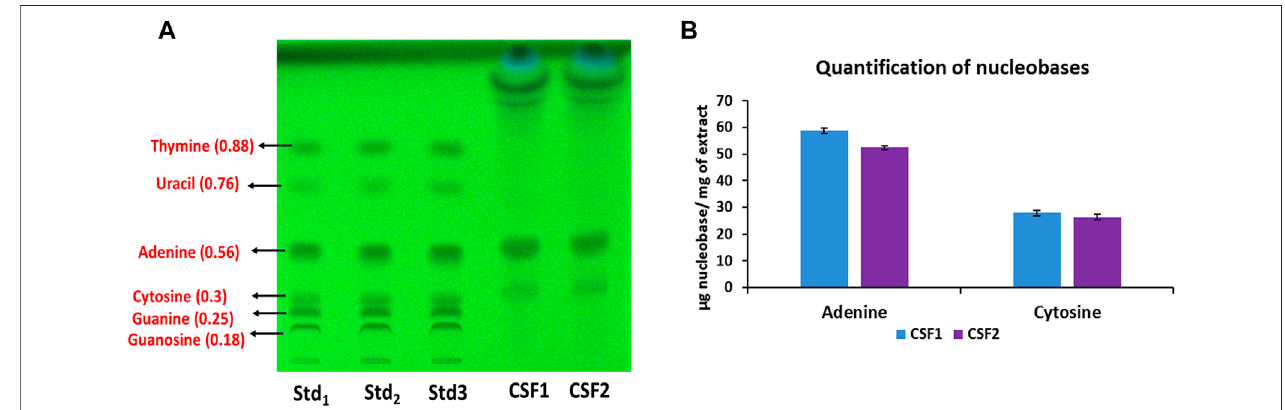
FIGURE3| HPTLCchromatogram at254 nmcon fi rmsthepresenceofadenineandcytosineinCSF1andCSF2extracts. Respective retardationfactor valuesare writteninparentheses (A) .Quantitiesdetectedfromdensitometric scanningarealsogiven (B) .Laneslabelled Std 1 ,Std 2 and Std 3 contain0.5,0.58and0.66 µgofeach standard nucleobase. Values for quanti fi cation are represented as mean ± SD ( n (cid:1) 3).